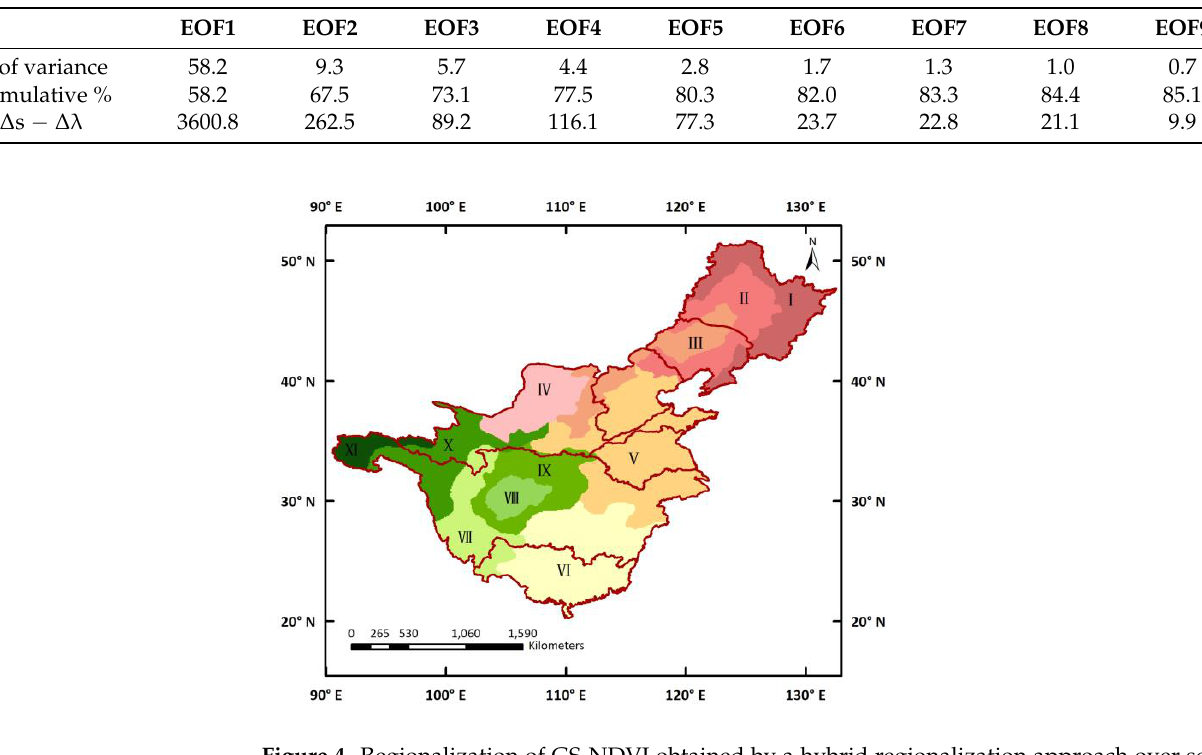
Figure 4. Regionalization of GS-NDVI obtained by a hybrid regionalization approach over seven major watersheds during 1982 – 2015.